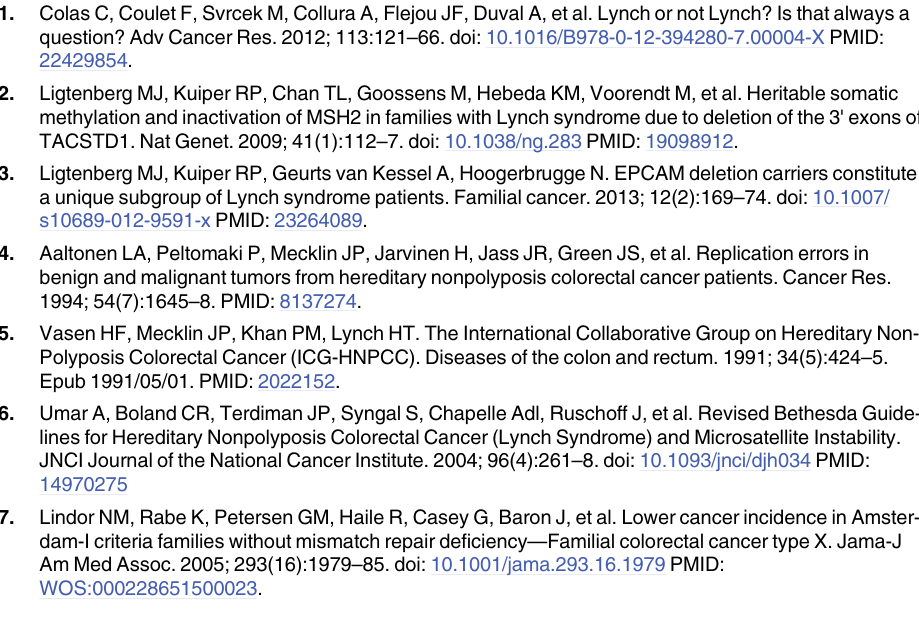
S1 Table. Overview of germline and somatic variants found in 34 sLS patients and 11 patients with an MLH1 hypermethylated